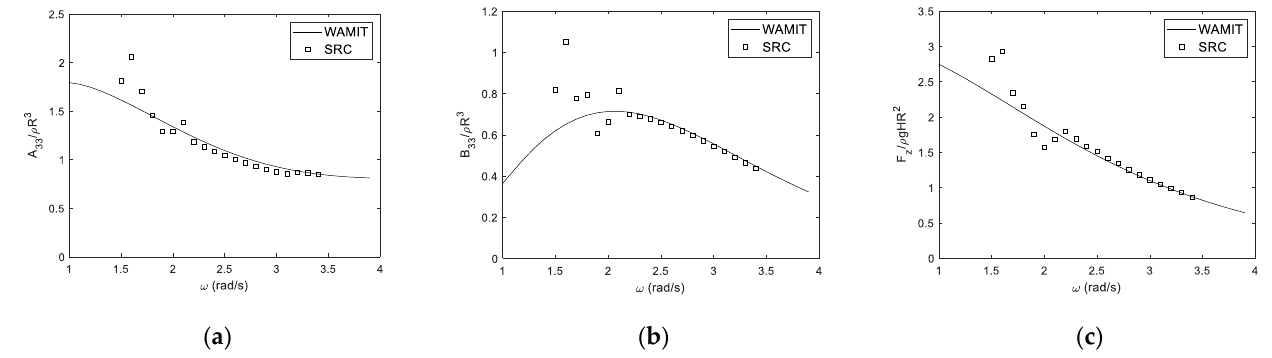
Figure 4. Comparison of heave added mass ( a ), heave radiation damping coefficient ( b ), and wave excitation vertical force ( c ) with Sommerfeld radiation condition.